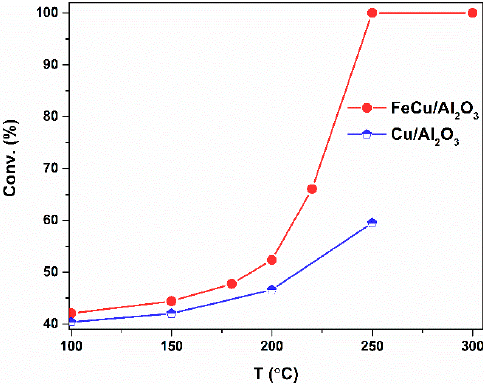
Figure 3. The temperature-dependent curve of the CO oxidation over the Al 2 O 3 -based catalysts. Re- action conditions: W cat = 0.3 g, F tot = 100 mL/min, P CO = 0.02 bar, O 2 /CO = 10/1, P tot = 1 bar.